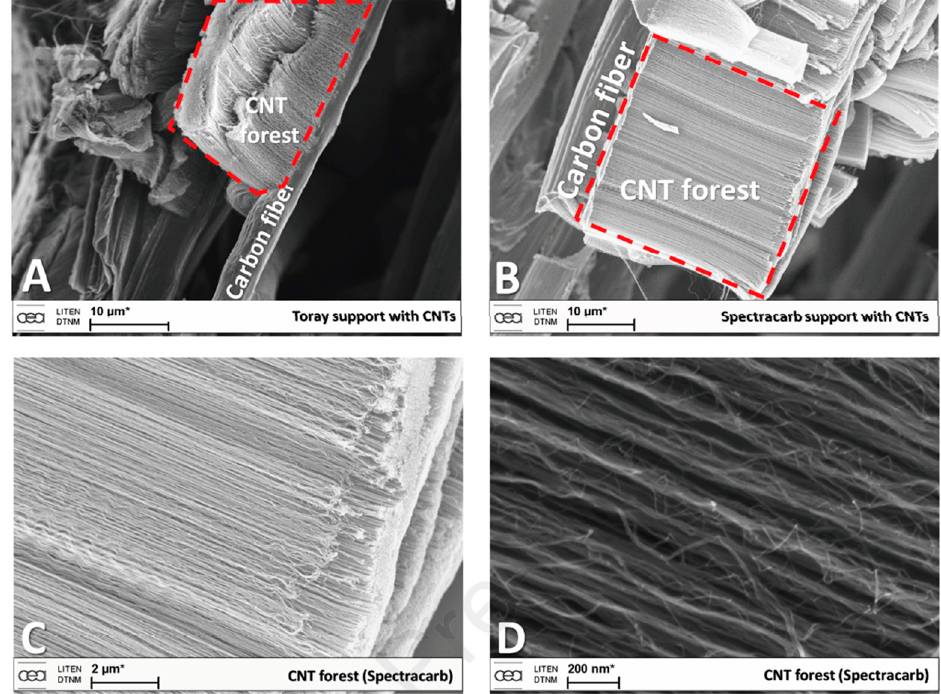
Figure 31. SEM micrographs of VACNT grown on CF of commercial GDLs with PVD pre-deposited TiAl/Fe DBL/catalyst layer. ( A ) low magnification of Toray GDL. ( B–D ) low, high, and highest magnification of Spectracarb GDL with grown VACNT, respectively. Reprinted with permission from Fontana, Carbon; Ref. [47] copyright 2020, Elsevier.